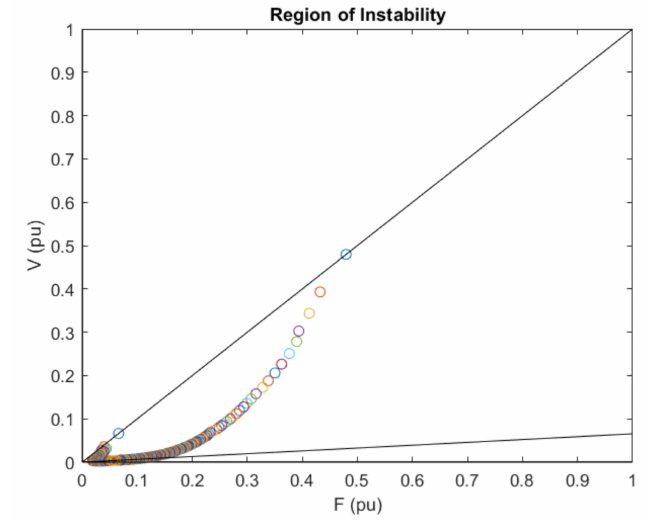
Figure 7. Region of instability in the V/f plane, (1 p.u.—0.06 p.u. V/Hz